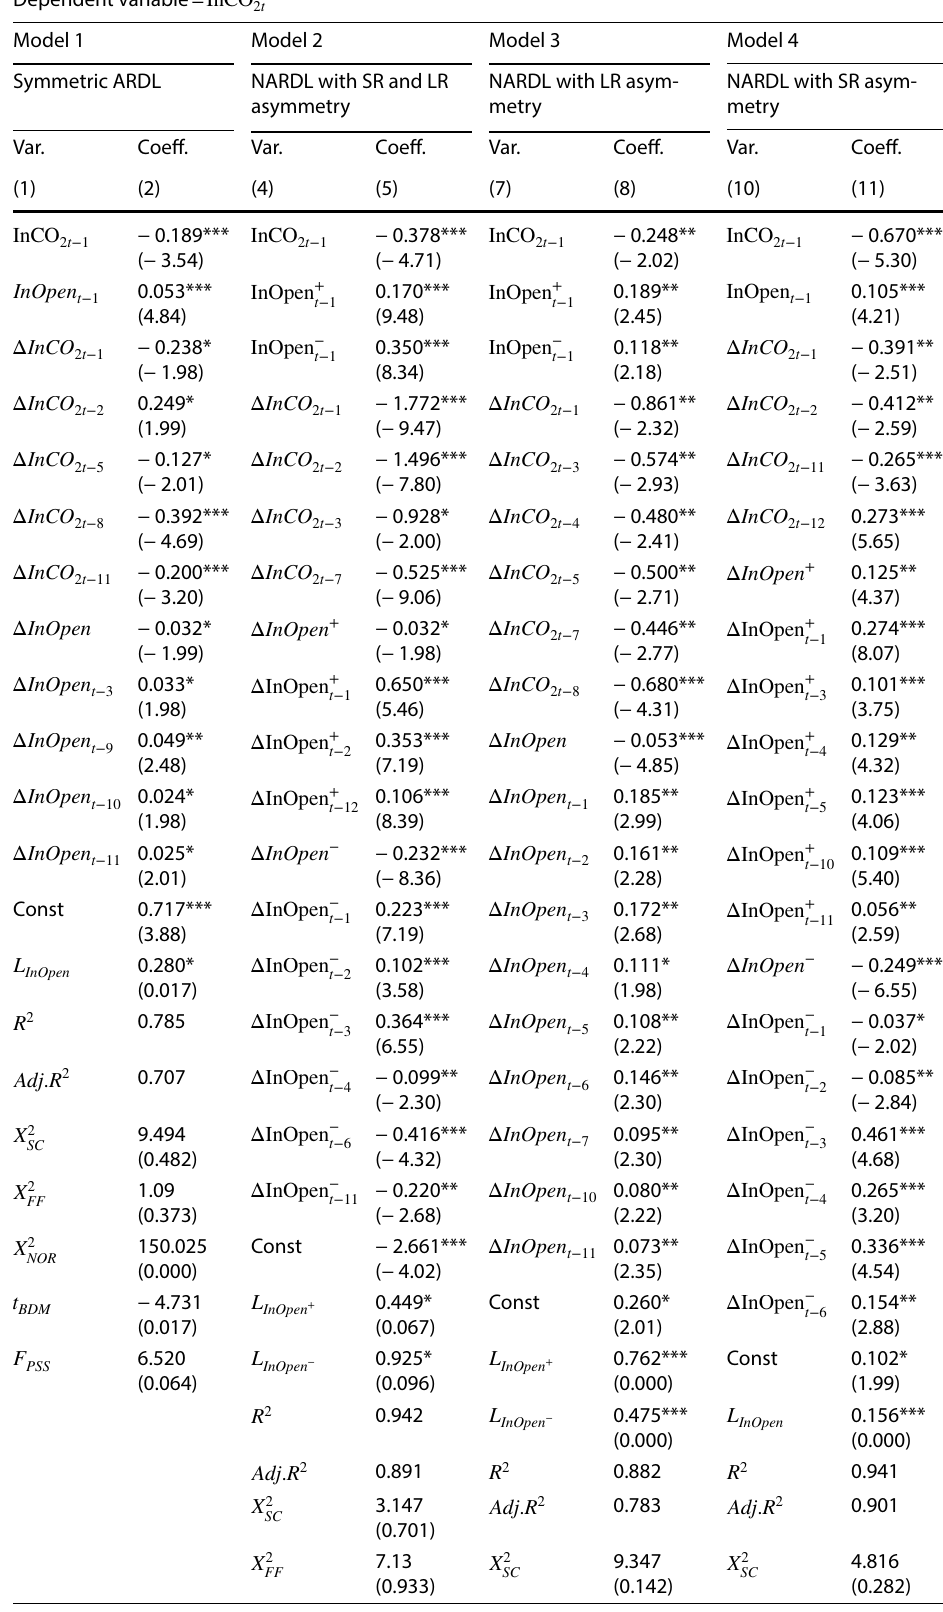
Table 14 Full-information estimates of both symmetric ARDL and nonlinear ARDL (NARDL) models in